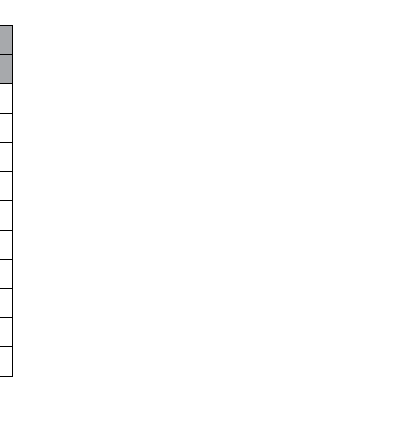
Table 3. Optical coherence tomography